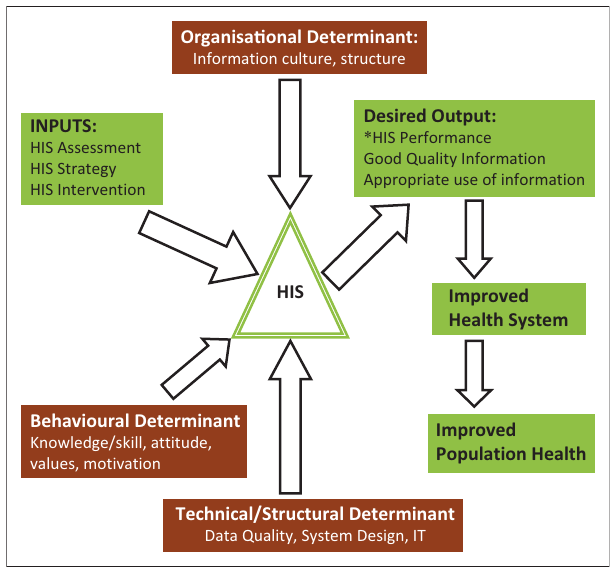
FIGURE 1: Performance of Routine Information System Management (PRISM) Conceptual